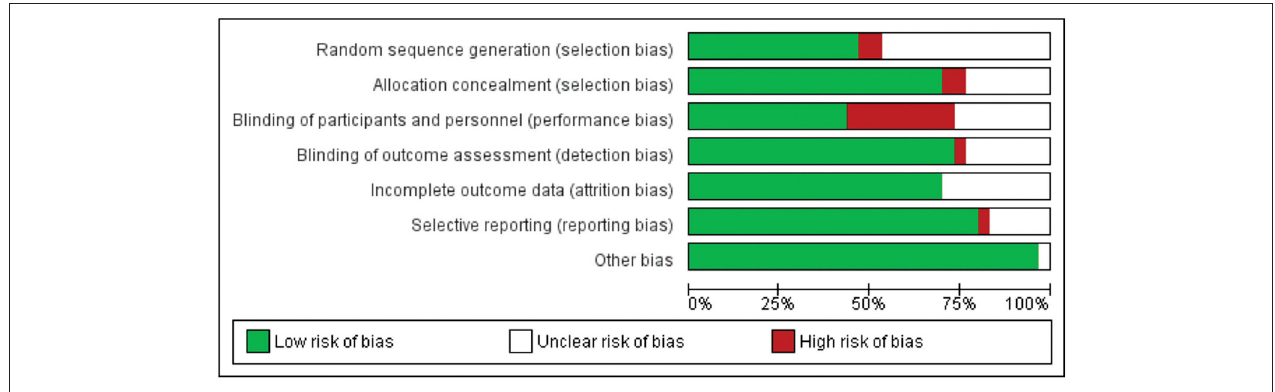
FIGURE 2 | Risk of bias evaluation of included